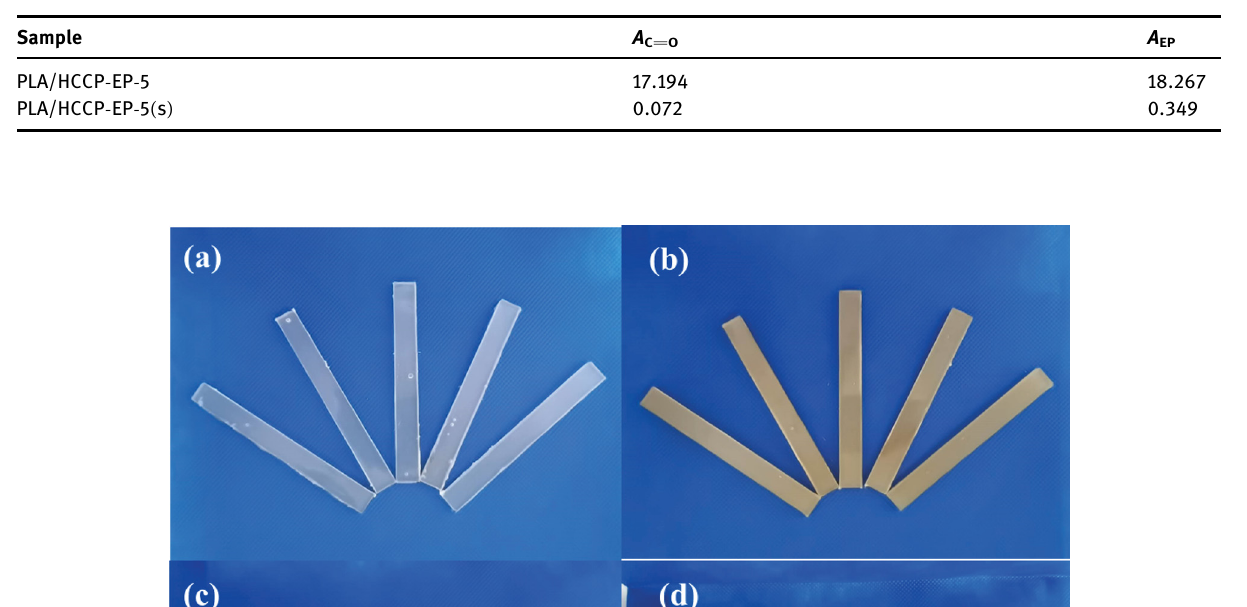
Table A1: The calculation results of A C ] O , A EP